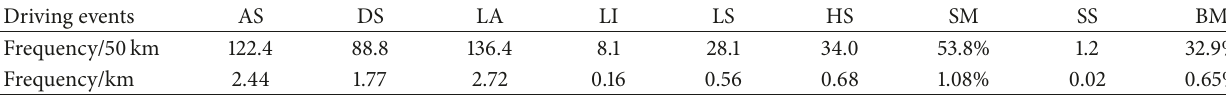
Table 2: Average frequency of driving events every 50 km and